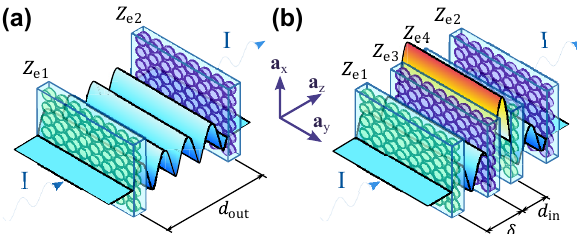
Figure 1: Conceptual illustration of the fields localized inside a single invisble cavity and two nested cavities. (a) Illustrations of a single invisible cavity formed by two parallel metasurfaces. Each metasurface consists of a uniform array of high-index disks. Disks shown with light blue color possess electric resonance slightly above the resonant frequency of the cavity (capacitive metasurface), while dark blue disks have the same electric resonance below the resonant frequency (inductive metasurface). The complex magnitude of the electric field is shown across the cavity, being constant outside the cavity and standing-wave–like within it. (b) Illustration of nested invisible cavities formed by four metasurfaces.